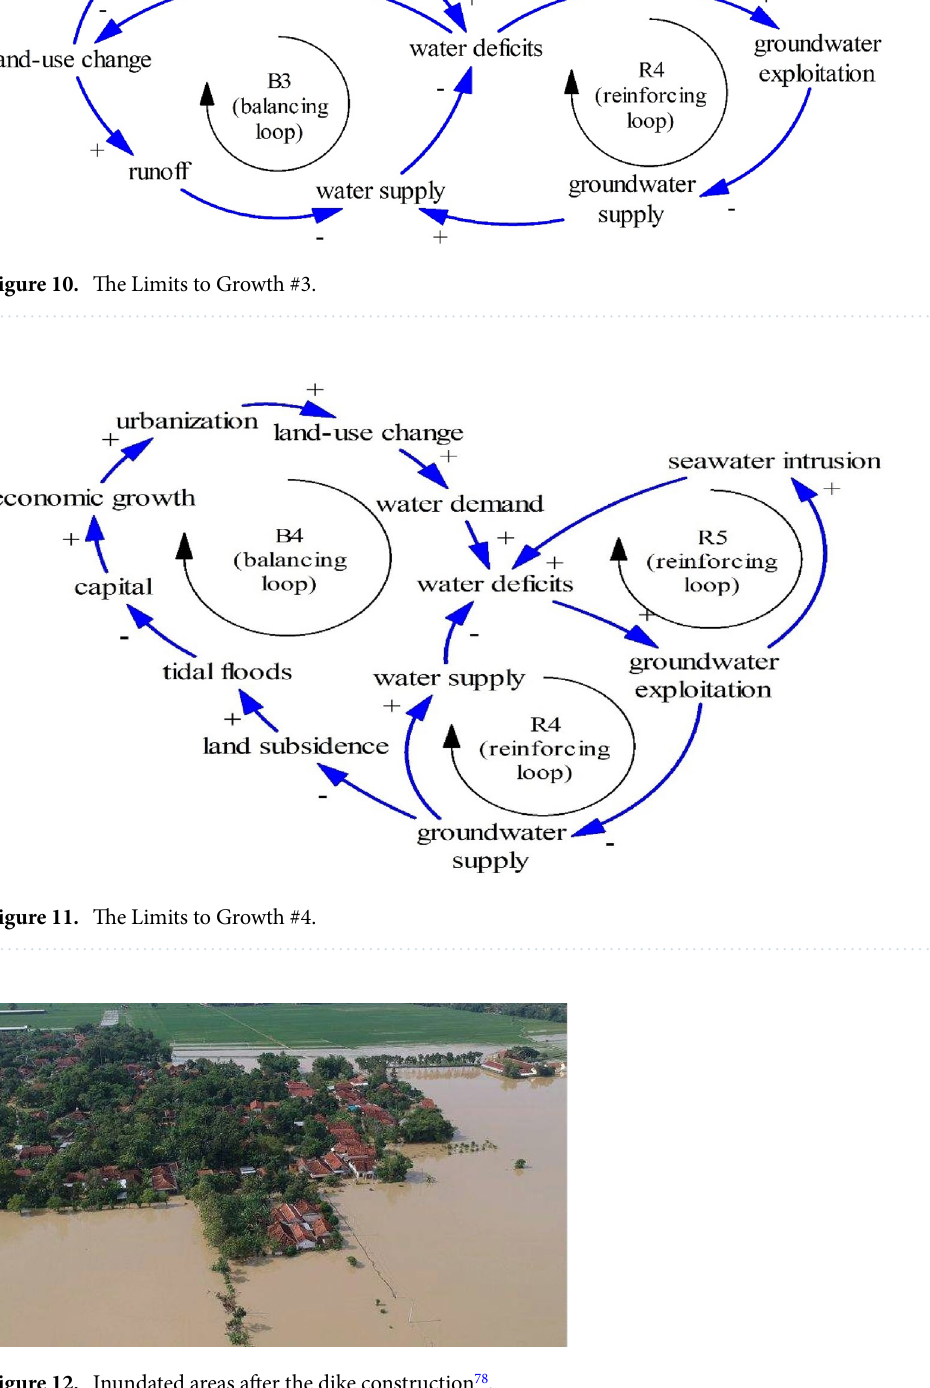
Figure 12. Inundated areas after the dike construction 78